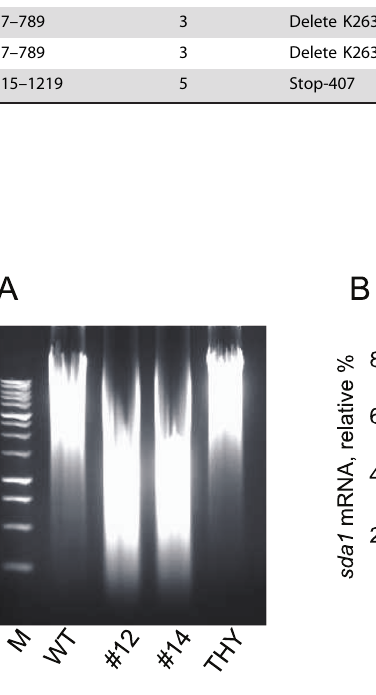
Figure 5. DNase activity and transcript levels in WT-5448/ CovR + S + and mouse-passaged clones of 5448/CovR + S 2 in culture supernatants. (A) Cultures of WT-5448/CovR + S + and clonal mouse-passaged 5448/CovR + S 2 isolates # 12 (skin) and # 14 (skin) were grown to mid-log phase (LP; A 600nm , 0.6) and their supernatants monitored for DNase activity. Supernatants were incubated with 1 m g of calf thymus DNA for 5 min at 37 u C. DNase activity was confirmed by visualizing DNA fragmentation by ethidium bromide staining and UV- light detection. THY in lane 5 represents the negative control. B , The effect of mouse-passaged GAS 5448 on sda1 gene expression is shown using mRNA isolated from washed cells harvested at mid-log phase (LP; A 600nm , 0.6) and early stationary phase (SP; A 600nm , 1.2) growth. WT- 5448/CovR + S + and mouse-passaged isolates (5448/CovR + S 2 ) # 12 (skin) and # 14 (skin) were employed. The relative % gene expression levels of the mouse-passaged strains are relative to those in WT-5448/CovR + S +